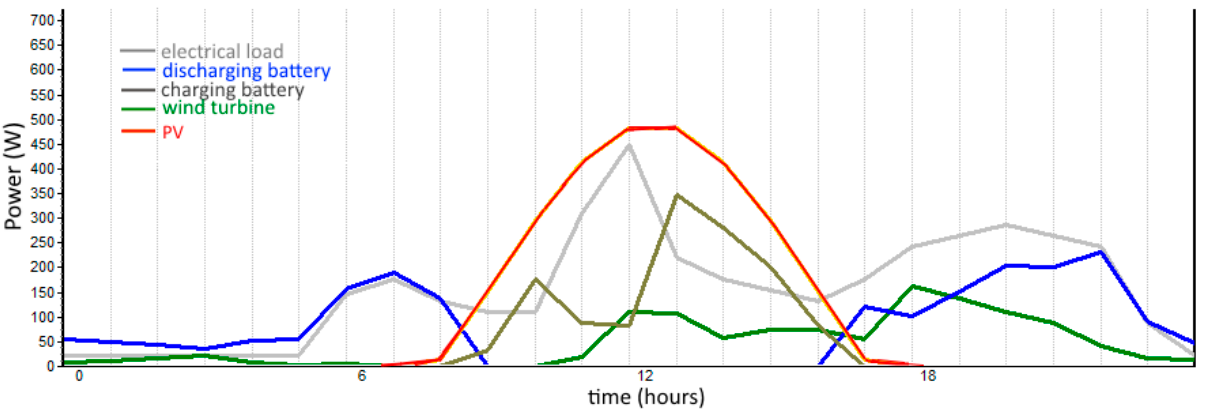
Figure 12. The waveforms for the iHOGA simulator.